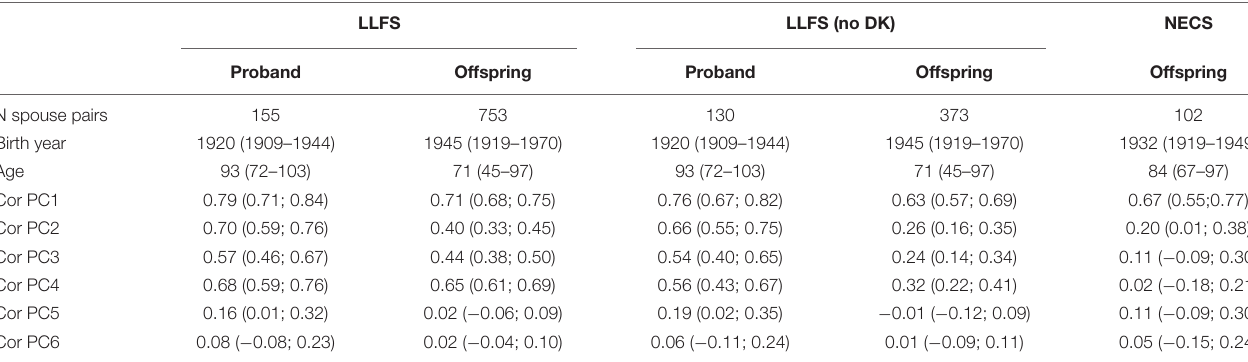
TABLE 1 | Summary statistics of spouse